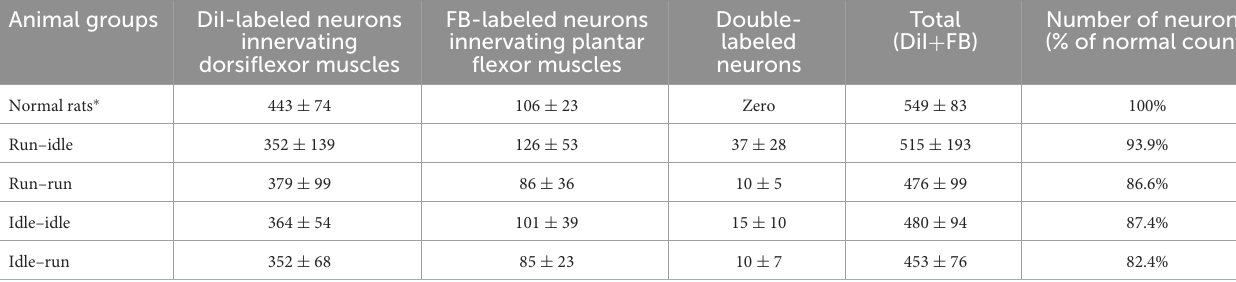
TABLE 1 Number of retrogradely labeled spinal